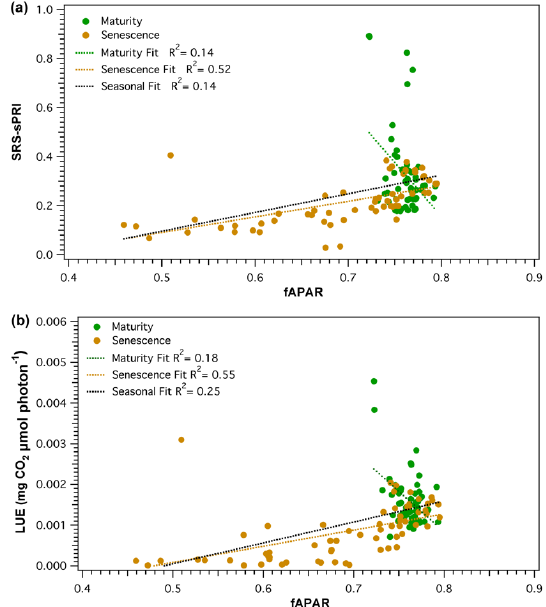
Figure 10. Relationship between fraction of absorbed photosynthetically active radiation ( f APAR) and ( a ) scaled photochemical reflectance index from SRS sensors (SRS-sPRI), and ( b ) light use efficiency (LUE). Comparisons are shown for the combined season (black) as well separated into maturity (green) and leaf senescence (brown) phenologic stages. .